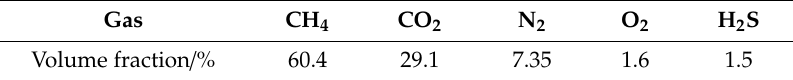
Table 3. The volume fraction of the main components in the biogas.